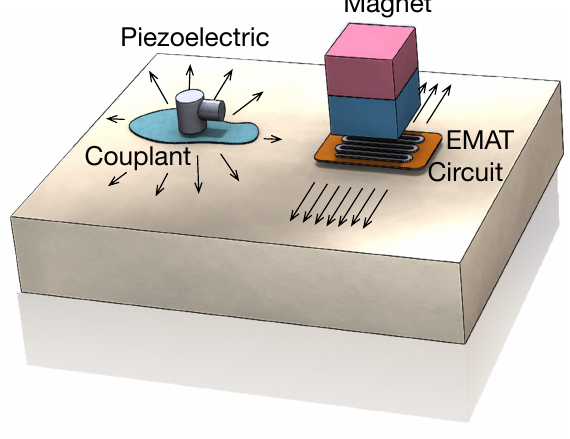
Figure 1. Conventional Ultrasound vs